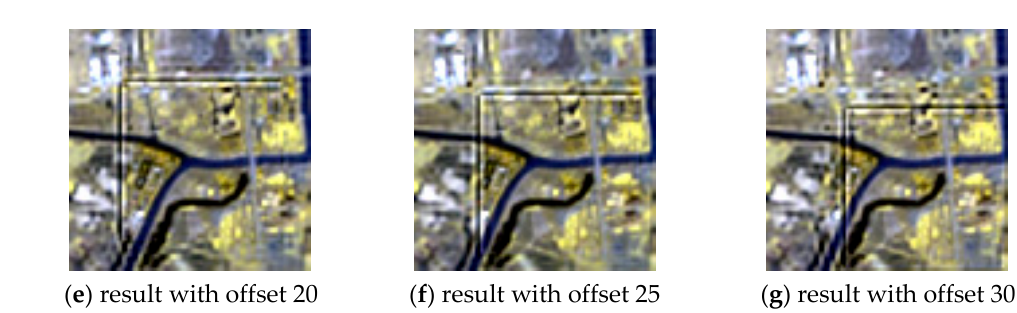
Figure 11. Visual performance with different offsets.